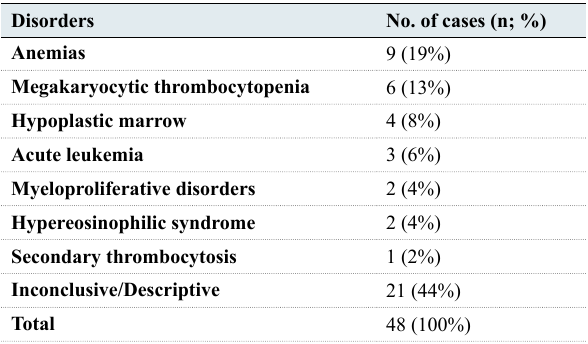
Table 1: Distribution of various hematological disorders in forty-eight cases.